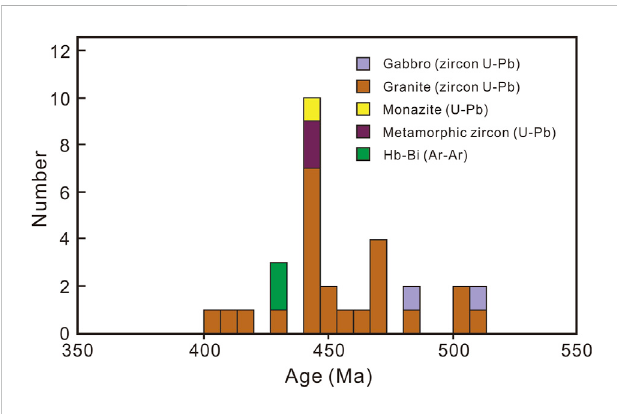
FIGURE 11 Histogram of the zircon U-Pb ages of the Granite, Gabbro, Monazite,and metamorphic zirconand mineral(hornblendeandbiotite) Ar-Ar ages for amphibolite-facies metamorphic rocks in SKT (data comes from Cui et al., 2006,Cui et al., 2007a, Cui et al., 2007b; Zhang X, B et al., 2007; Zhang et al., 2016; Zhang L. N. et al., 2019).